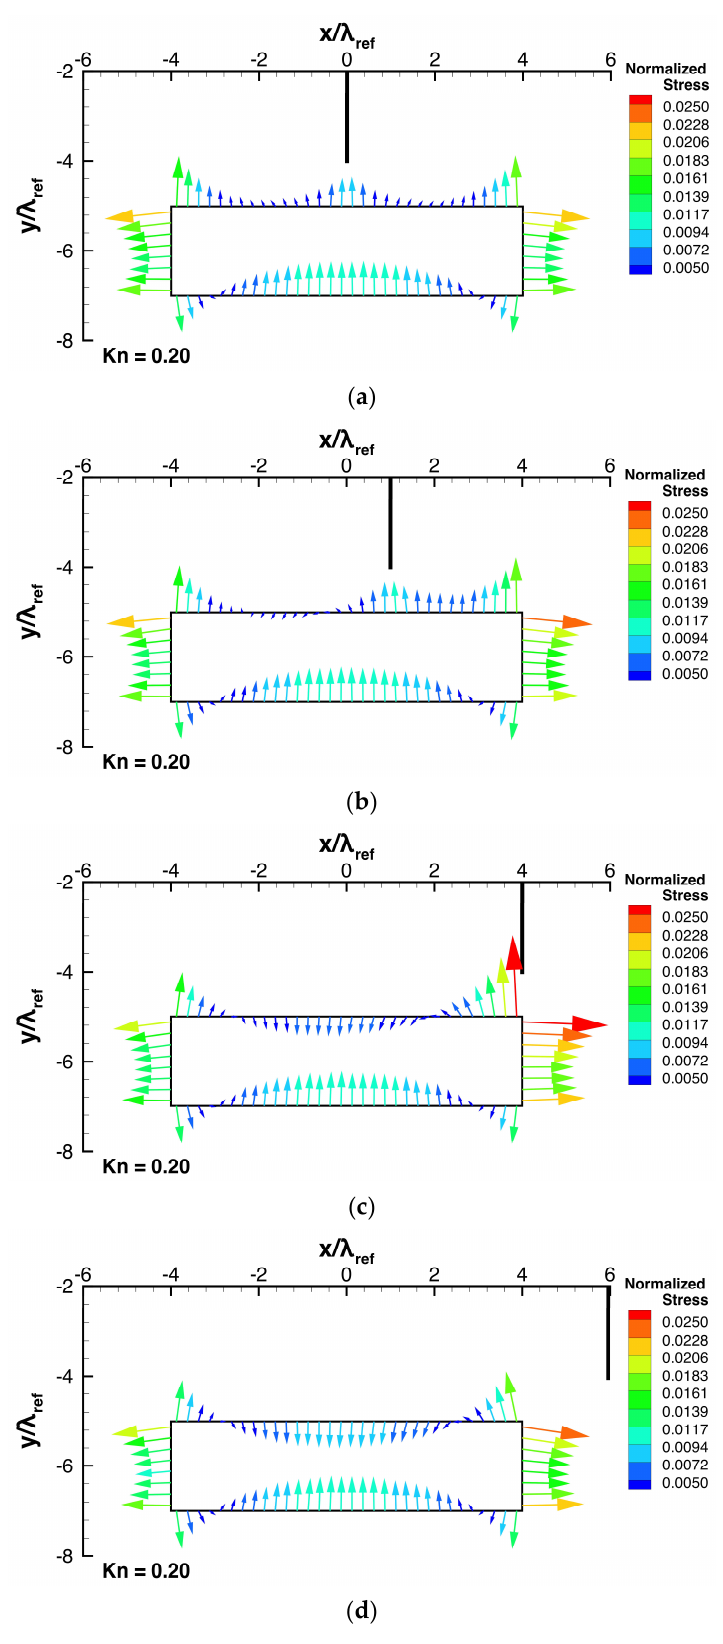
Figure 7. Stress distributions for different deviation distances, l dev , at Kn = 0.2. ( a ) l dev = 0 . ( b ) l dev = 0.125 w . ( c ) l dev = 0.5 w . ( d ) l dev = 0.75 w